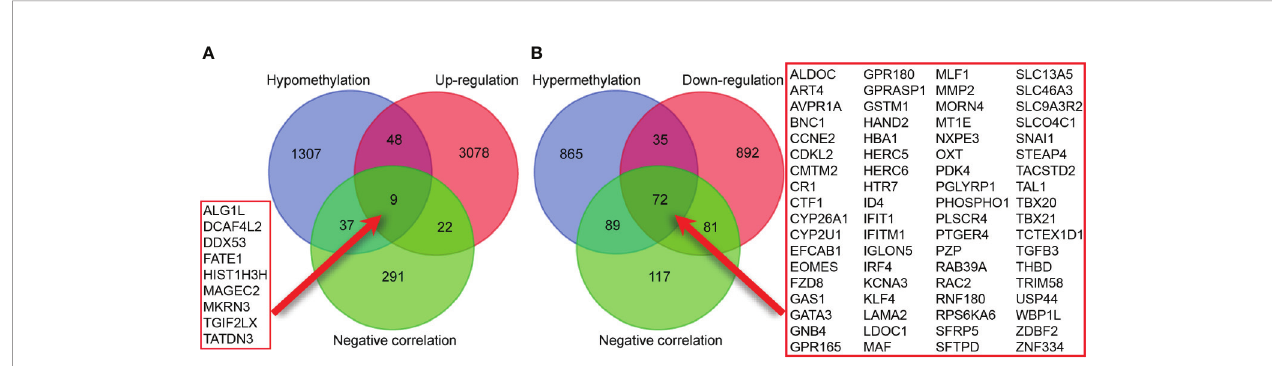
FIGURE 2 | Identi fi cation of methylation-regulated differentially expressed genes (MeDEGs). (A) A total of nine genes were identi fi ed as MeDEGs by intersecting three gene sets (hypomethylation, up-regulation, and negative correlation). (B) A total of 72 genes were identi fi ed as MeDEGs by intersecting three gene sets (hypermethylation, down-regulation, and negative